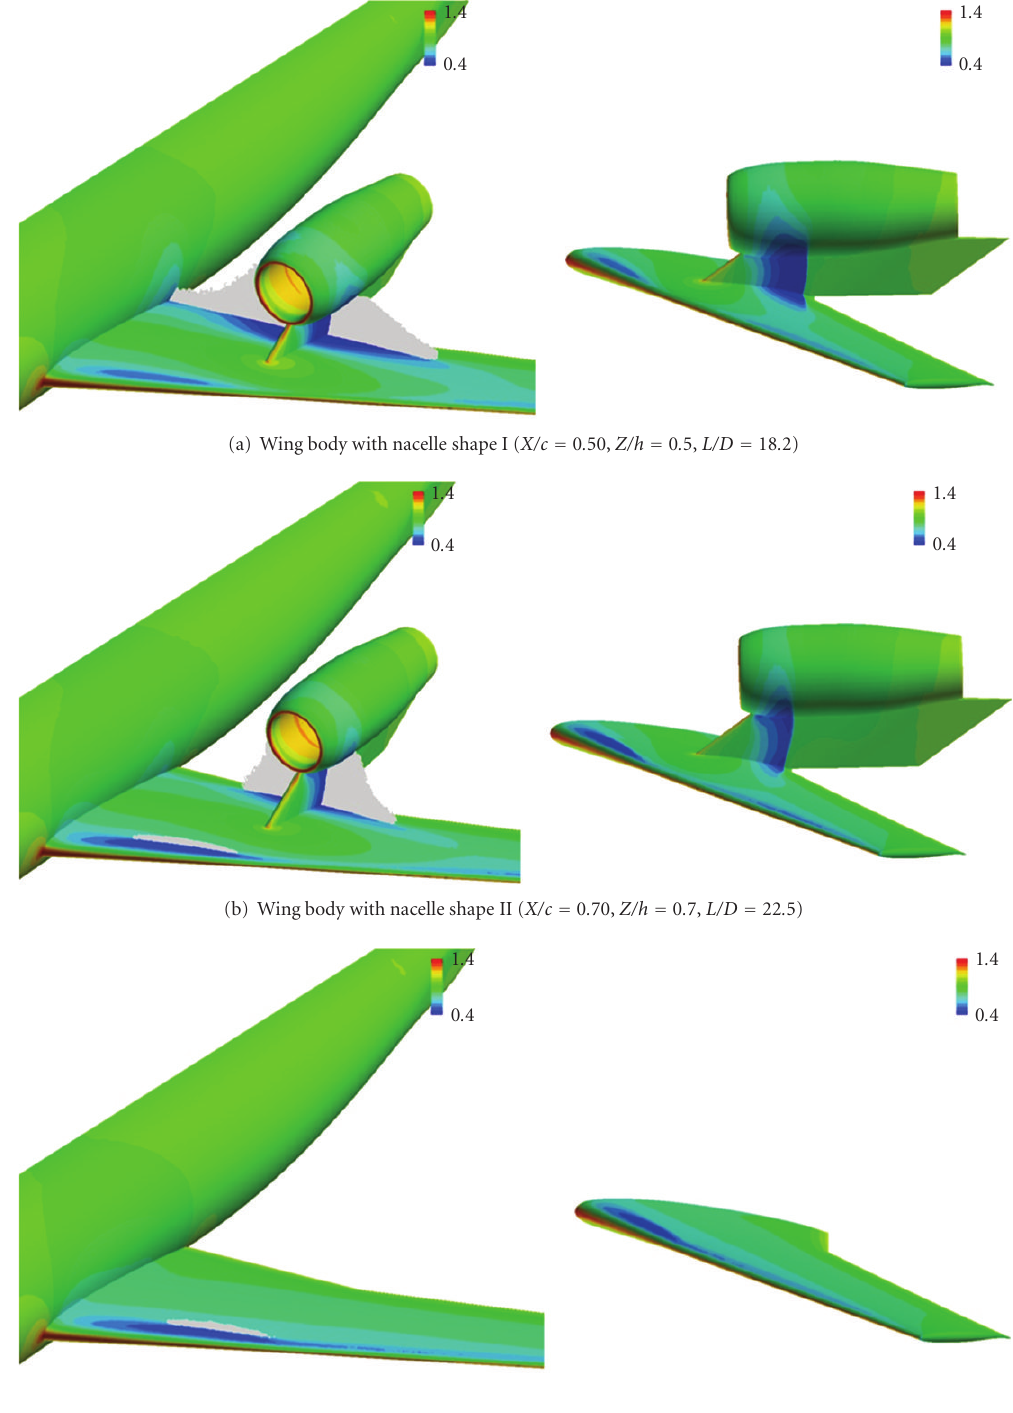
Figure 4: Three wing body configurations with/without nacelle.